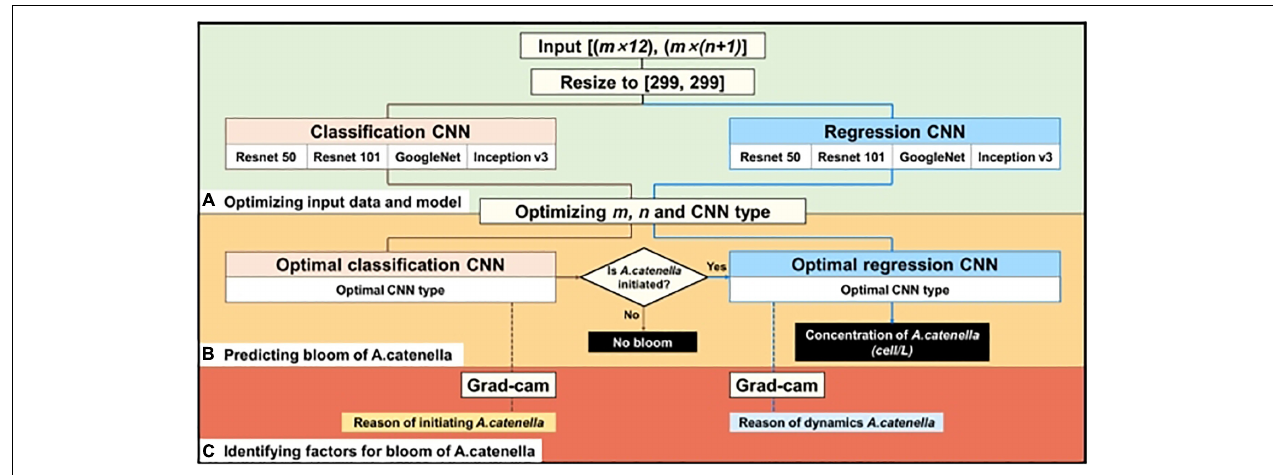
FIGURE 3 | Procedure of simulating A. catenella using CNN— (A) optimizing input data and CNN structures, (B) predicting bloom of A. catenella based on optimal input and structures, and (C) identifying factors for bloom of A. catenella using Grad-CAM. Brown and blue lines indicate the processes of classification and regression CNN models,